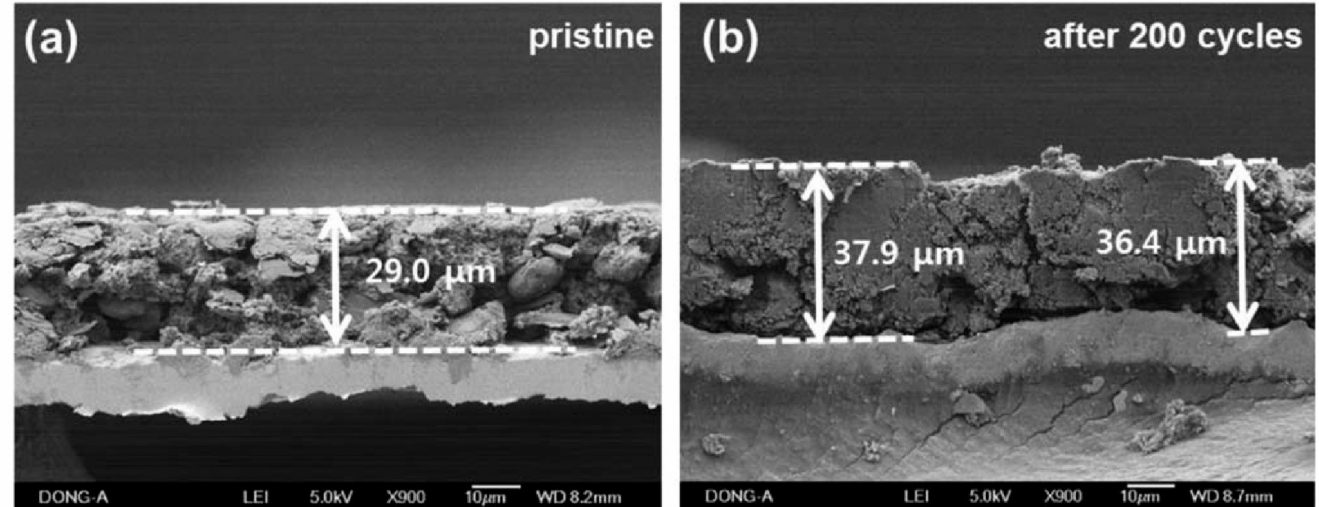
Figure 19. Morphological analysis of a cross-section of Si/graphene sheet/carbon (Si/GS/C)-S@Gr before and after cycling; ( a ) before and ( b ) after cycling for 200 cycles. Adapted and reproduced with permission from Ref. [86]. Copyright 2016